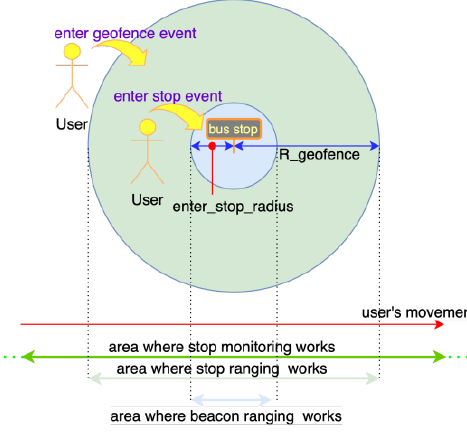
Figure 2. Detecting enter stop.